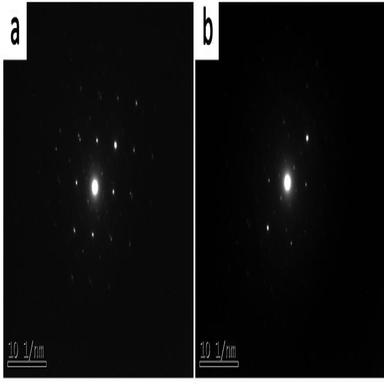
SAED patterns of Li1.2Ni0.15Co0.1Mn0.55O2 (a) CLNs and (b) AMs.